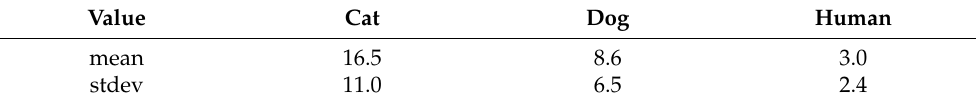
Table 2. Mean and standard deviation of the distribution of the pixel-wise absorption to the dark-field image gray-value ratio, a dimensionless quantity, taken over different stones types obtained by